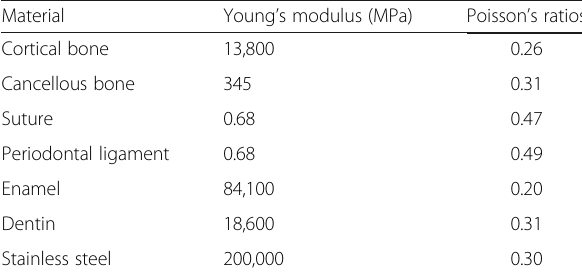
Table 1 Material ’ s mechanical properties used in this study